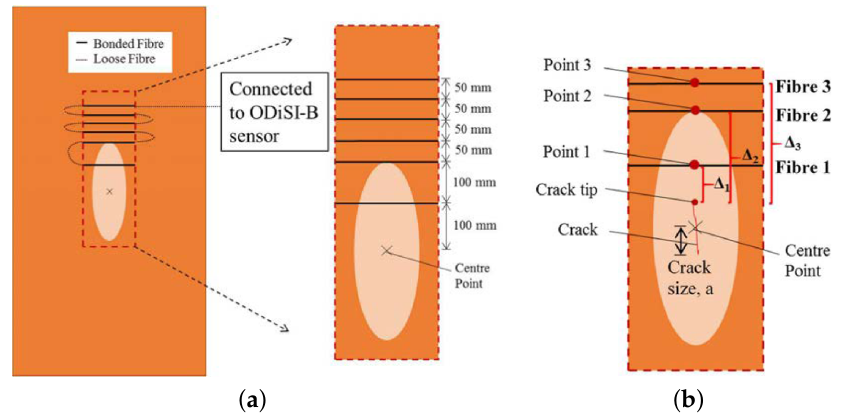
Figure 30. The principle of operation of the coherent OFDR scheme. Reprinted under Creative Commons CC BY license [114].